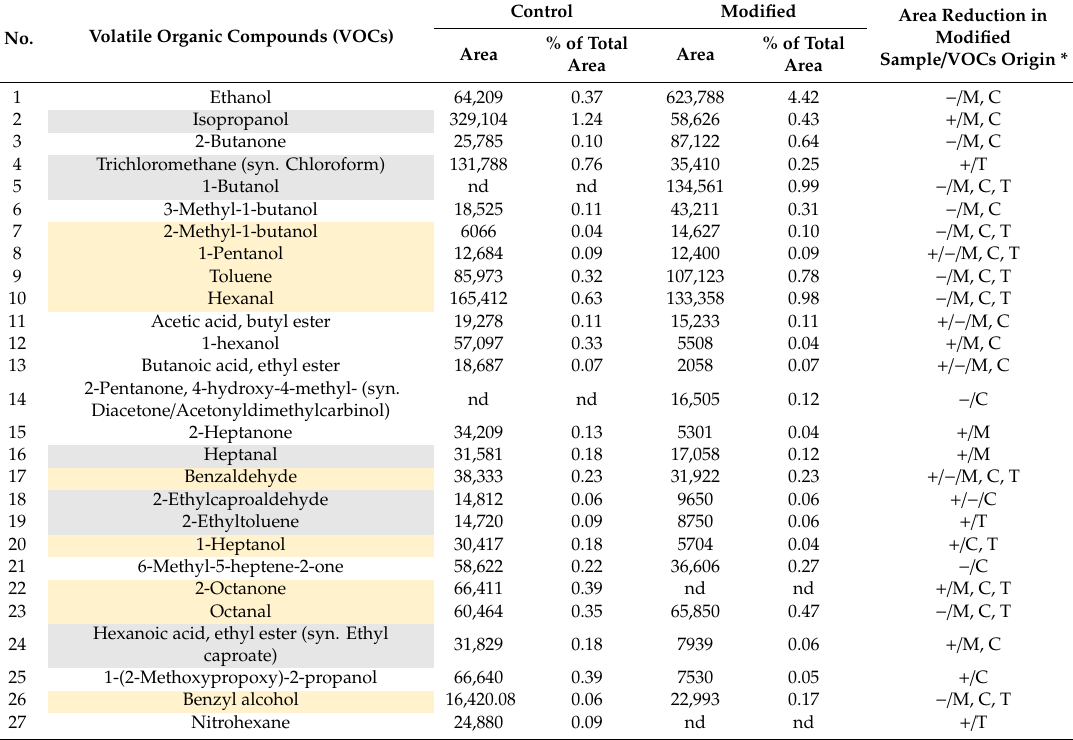
Table 6. Volatile organic compounds identified in the air above towels (control and modified) after seven days of use in di ff erent light